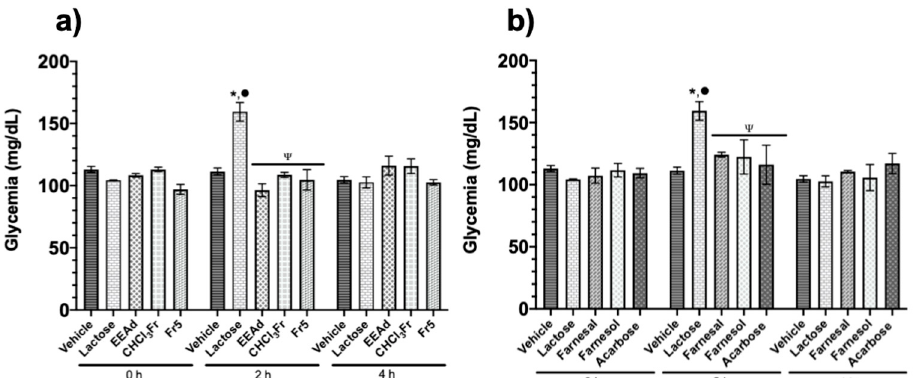
Figure 2. Effect of products isolated from A. diversifolia and acarbose on the oral lactose tolerance test (OLTT). ( a ) Groups treated with vehicle, lactose (3 g / kg), EEAd, CHCl 3 Fr (200 mg / kg), and Fr5 (50 mg / kg). ( b ) Groups treated with vehicle, lactose (3 g / kg), farnesal, farnesol, and acarbose (50 mg / kg). Data are expressed as means ± SEM, n = 6; * p < 0.05 vs. initial values; • p < 0.05 vs. vehicle for 2 h; Ψ p < 0.05 vs. lactose for 2 h.